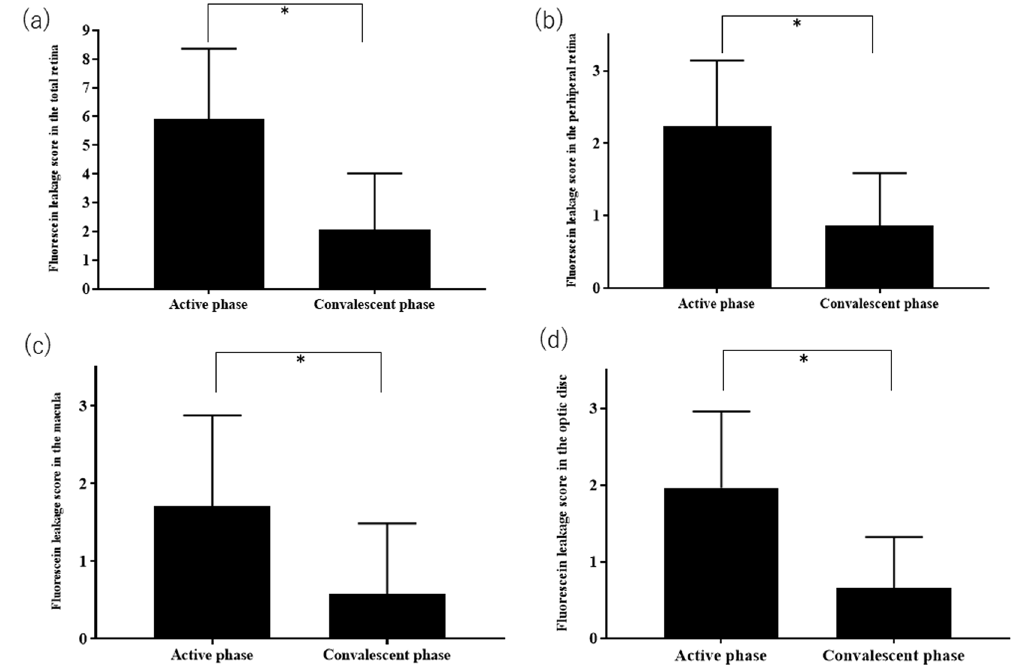
Figure 2. Changes in fluorescein angiography (FA) leakage score in the total retina ( a ), peripheral retina ( b ), macula ( b ), and optic disc ( d ) between the active and convalescent phases. In all areas investigated, the FA leakage scores are significantly higher in the active phase compared with the convalescent phase. Data are presented as mean ± SD. Statistical analyses were performed using the paired t-test ( * p < 0.05).